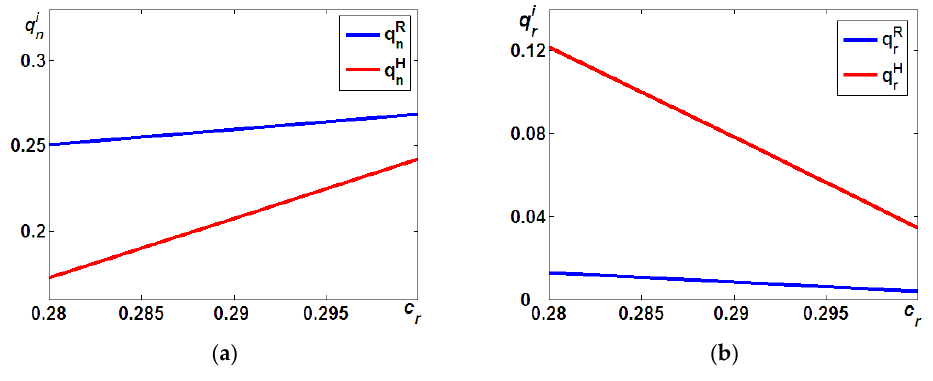
H R H n vs. q n ; ( b ) q r vs. q r .